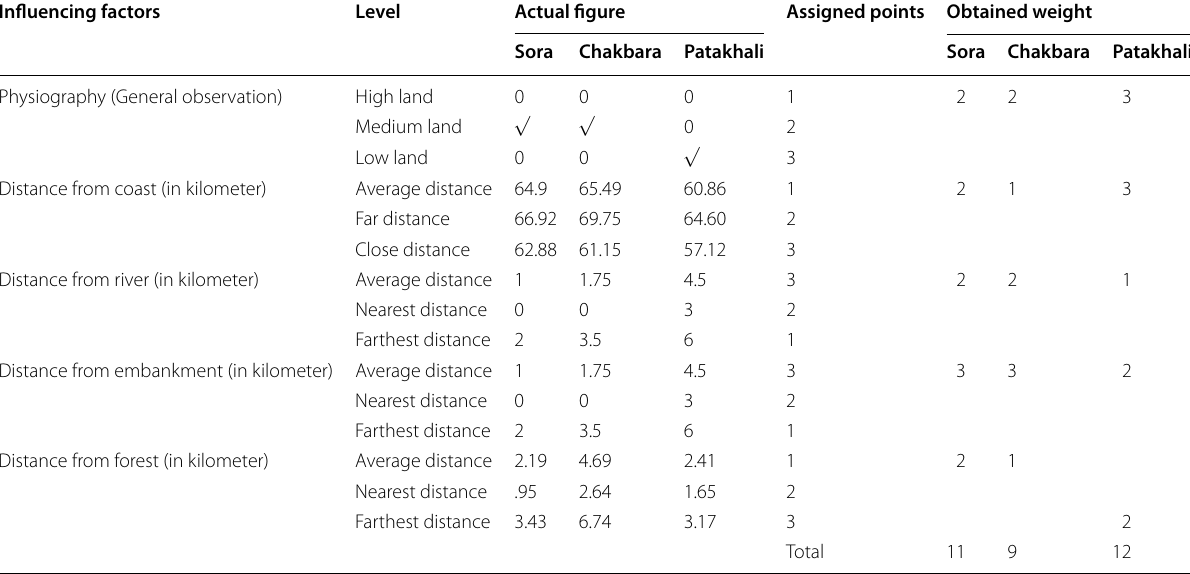
Source Field Survey 2017